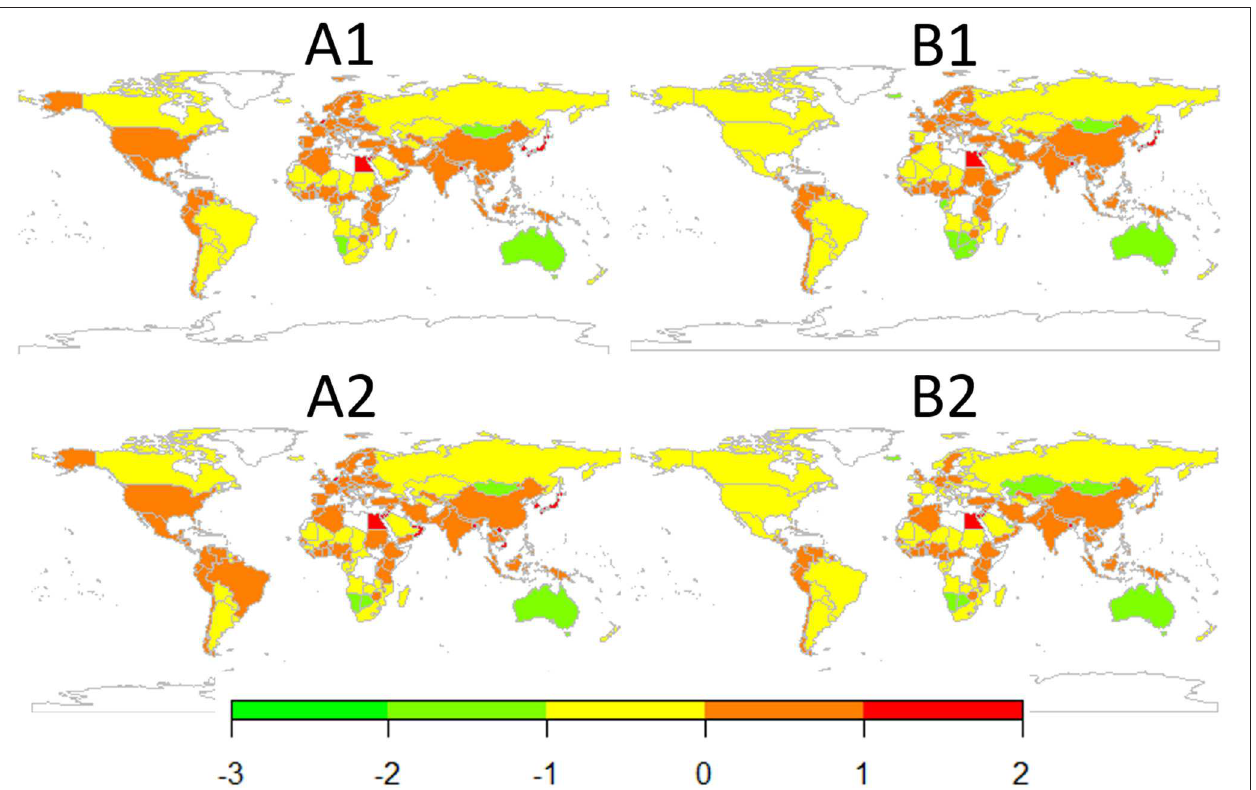
FIGURE 2 | The ratio of each country’s land needed to meet animal-based energy demands in the scenarios A1–B2 in the year 2070, 2060, 2060, 2090, respectively, to its current agricultural land use, using policy code 904. A log 10 scale is employed.